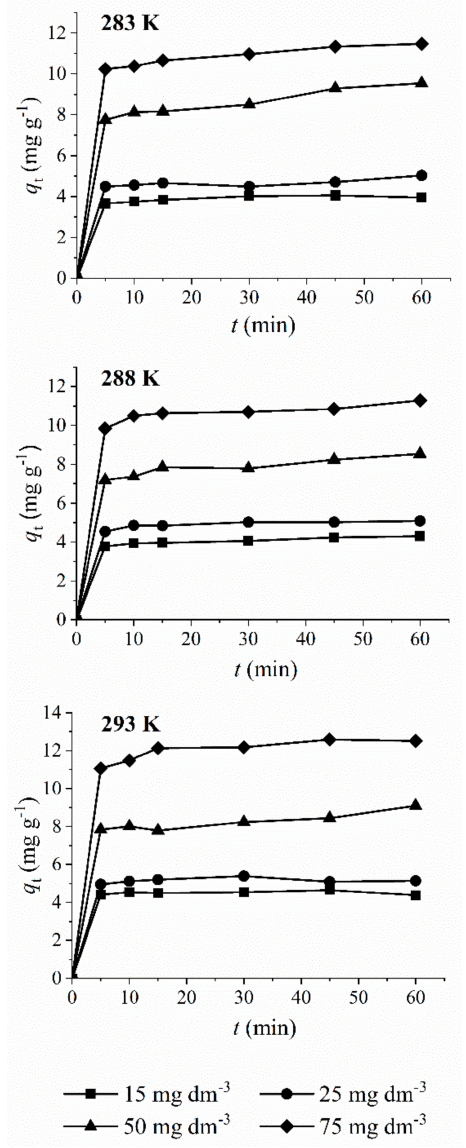
Figure 11. Adsorption kinetics for CIP on CLI for different temperatures; q t is the amount of the adsorbed CIP (mg per 1 g of CLI) after time t